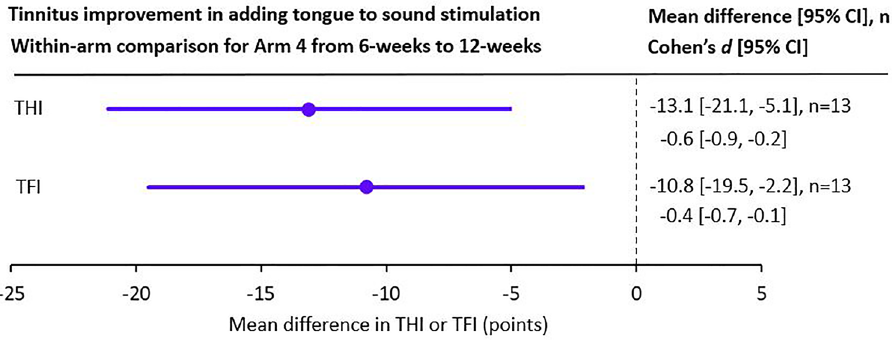
Figure 7. Changes in tinnitus symptom severity for arm 4 between interim and final visits after adding tongue stimulation to sound-only stimulation. Mean change in THI or TFI and 95% CIs are plotted between 6-week (interim) and 12-week (final) visits for all participants who were compliant to treatment (defined as ≥ 18 h at interim and ≥ 36 h at final). There is a significant improvement in tinnitus symptom severity after adding tongue stimulation (PS6) to sound-only stimulation (PS9), supporting the criticality of combining tongue stimulation with sound to drive additional therapeutic benefit for tinnitus. Post-hoc statistical analysis was based on a paired two-tailed t-test ( P < 0.05; 95% CI does not overlap the vertical line at zero; P = 0.0039 for THI and P = 0.0180 for TFI). Cohen’s d effect size and 95% CI are also listed for THI and TFI on the right side of the figure. Note that n is equal to 13 instead of 14 as in Fig. 6 for arm 4 because compliance criteria of both 18 h and 36 h (rather than just one of them) must be satisfied by each participant to be included in the